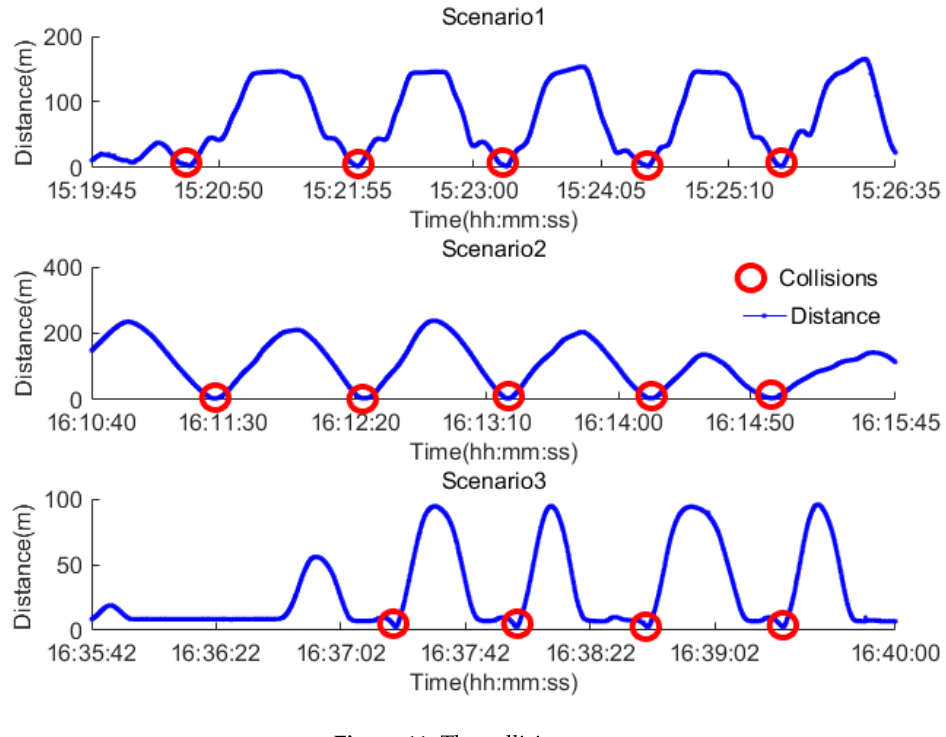
Figure 11. The collision tests.